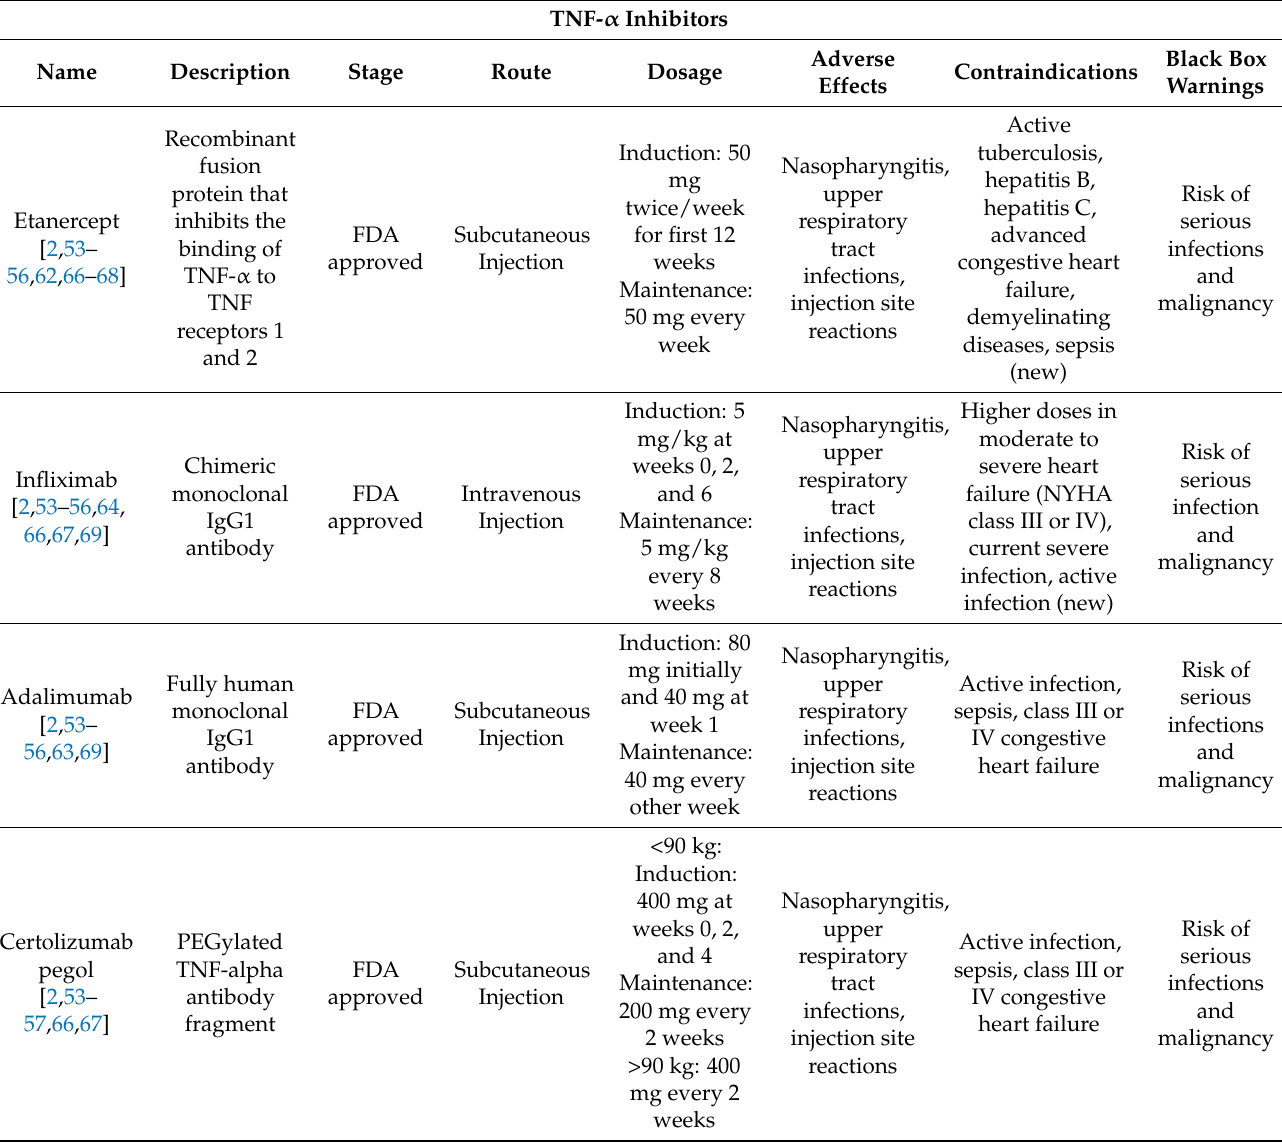
Table 1. Summary of TNF- α Inhibitors for